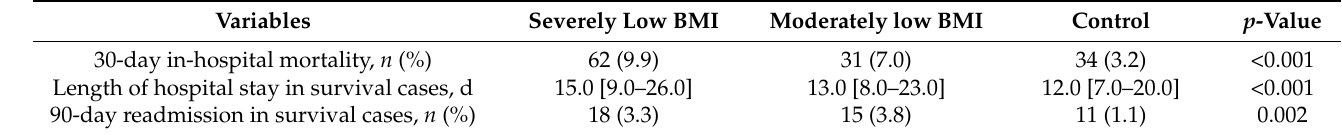
Table 2. Comparison of outcomes by the severity of low BMI in Asians.